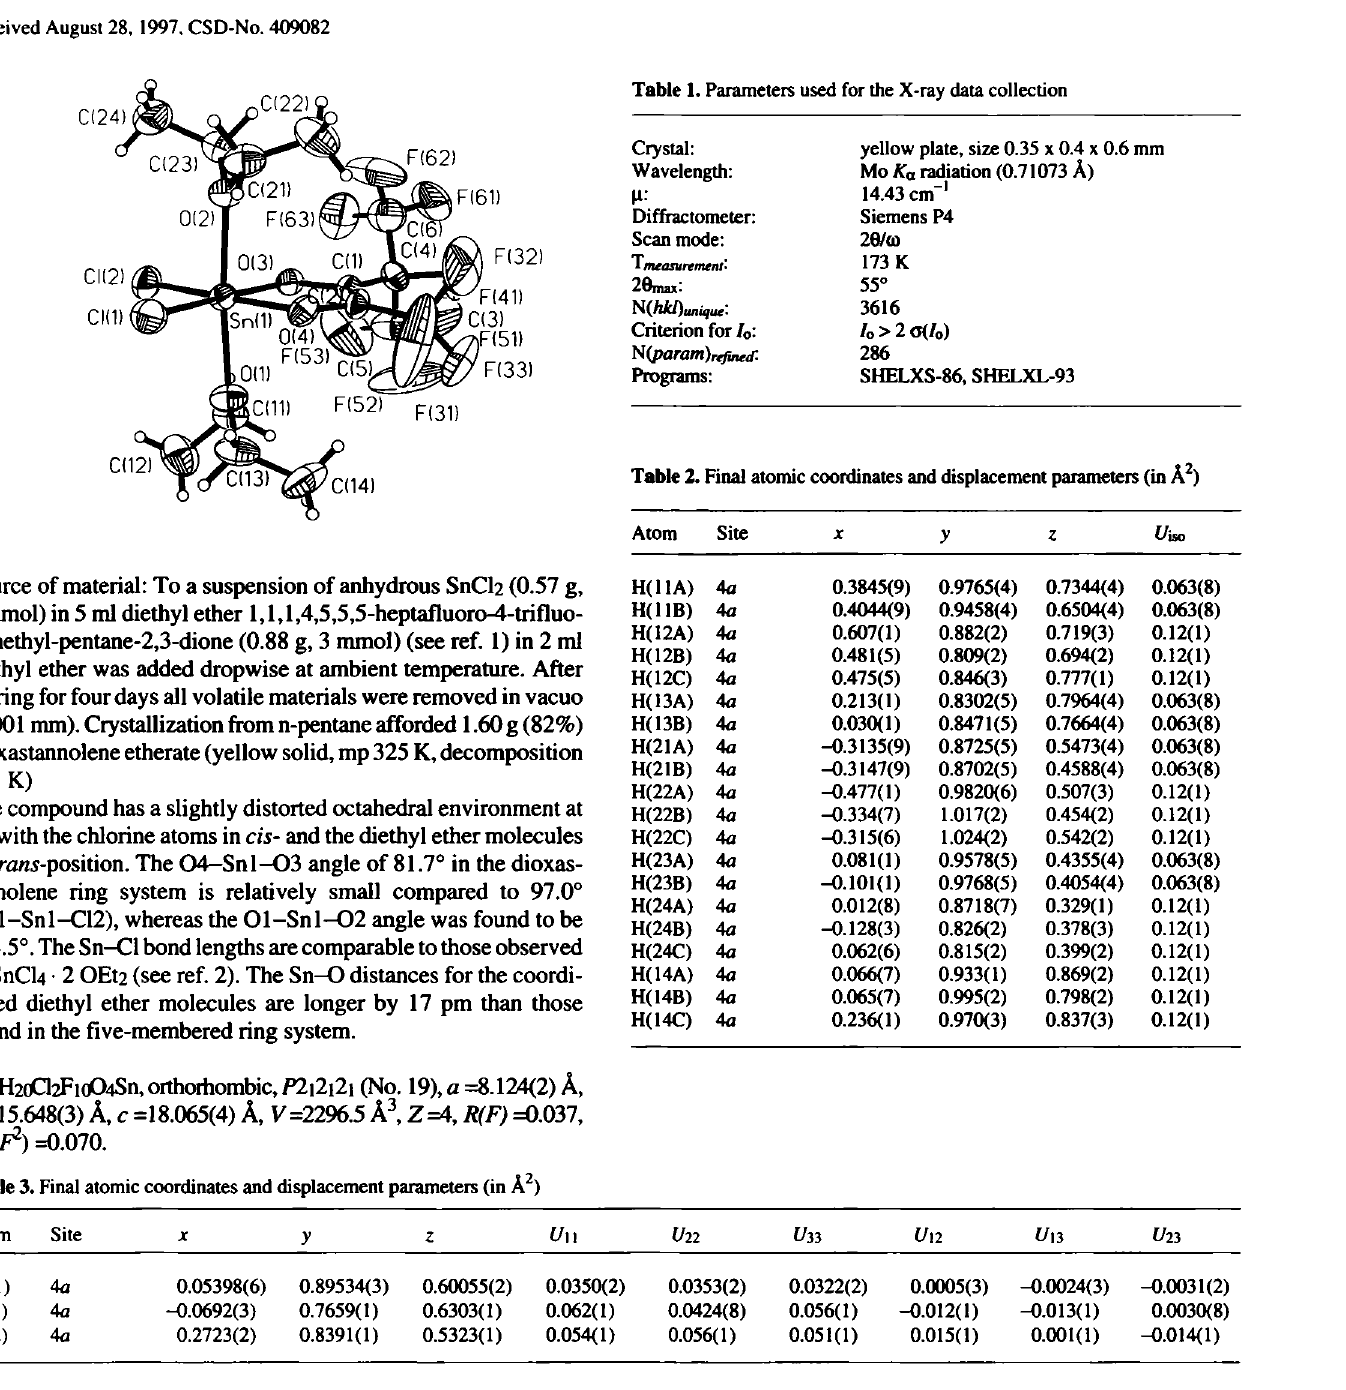
Table 1. Parameters used for the X-ray data collection